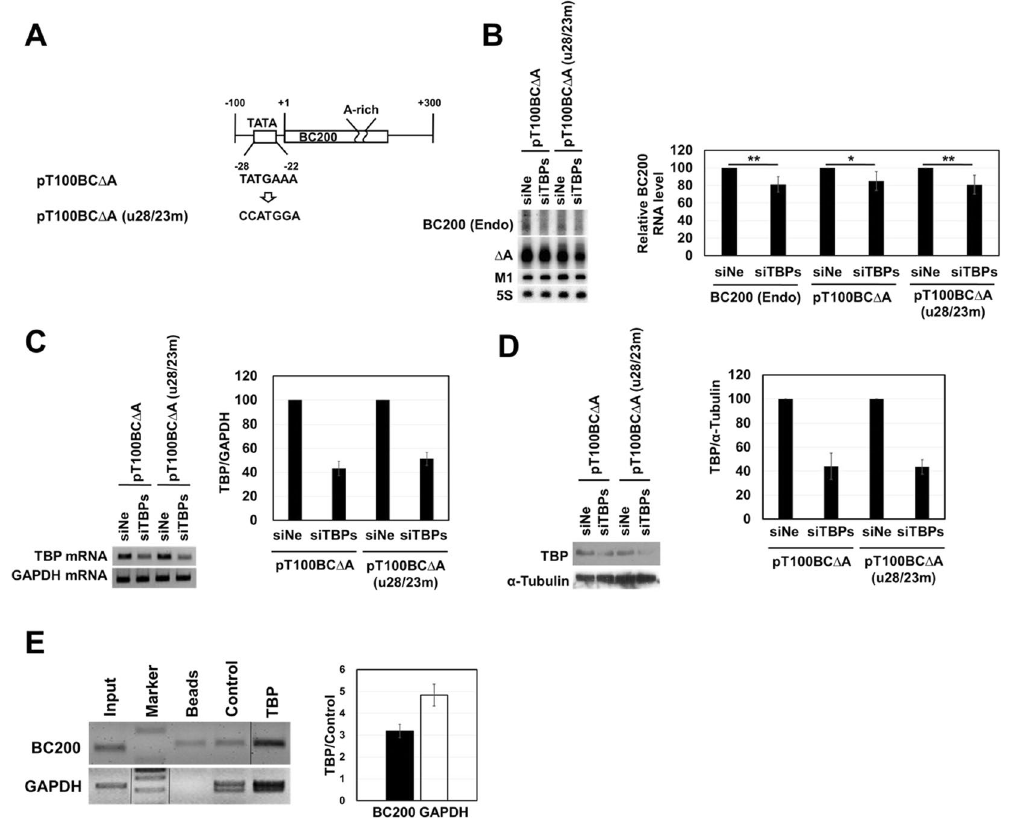
Figure 2. Effects of TBP on BC200 RNA transcription. ( A ) The putative TBP binding site (TATA box) and the mutated sequence (CCATGGA) are shown. ( B ) The effects of TATA-like sequence mutation (u28/23 m) and TBP knockdown on BC200 RNA transcription were examined. The − 100 nt upstream constructs expressing RNA Δ A with or without u28/23 m were introduced into HeLa cells treated with a mixture of TBP siRNAs (siTBP#1, #2, and #3) or a negative siRNA (siNe). The cells were transfected with 0.75 µ g of plasmids expressing BC200 RNA or its derivatives, 0.5 µ g of the M1 RNA expressing plasmid, and 15 pmole of each siRNA. RNA transcription levels were determined by Northern blotting. Three independent experiments were carried out. The relative expression levels of endogenous BC200 RNA and exogenous RNA Δ A were calculated by dividing their Northern blot signals by those of the M1 RNA after both sets of signals were normalized with respect to the 5S rRNA signal. The ratio of expression in siTBP-treated cell to that in siNe-treated control cells is presented. * P < 0.05; ** P < 0.01. ( C and D ) TBP knockdown was confirmed by semi qRT-PCR of TBP mRNA using GAPDH mRNA as a control (panel C), and by Western blotting of TBP protein using α -tubulin as a control (panel D). The amount of TBP mRNA was quantified by qRT-PCR and proteins was quantified using the ImageJ software. The knockdown efficiency was about 50% on both mRNA and protein levels. ( E ) ChIP analysis. TBP antibody-bound DNA fragments were used as PCR templates for amplifying the sequence between positions − 100 and + 30. TBP refers here to the TBP antibody; Beads refers to rProtein G-agarose beads alone; and Control indicates rabbit preimmune serum, which was used as a control antibody. A positive control ChIP assay was also carried out with the GAPDH promoter. Marker, DNA size marker. Input, a parallel analysis with 0.5% of the sheared formaldehyde-crosslinked-chromatin. The PCR products were analyzed by agarose gel electrophoresis ( left ) or the enrichment of PCR products relative to Control was analyzed by qPCR ( right ). BC200 (Endo), endogenous BC200 RNA. The spliced images from the same agarose gel were shown with the insertion of dividing lines between spliced